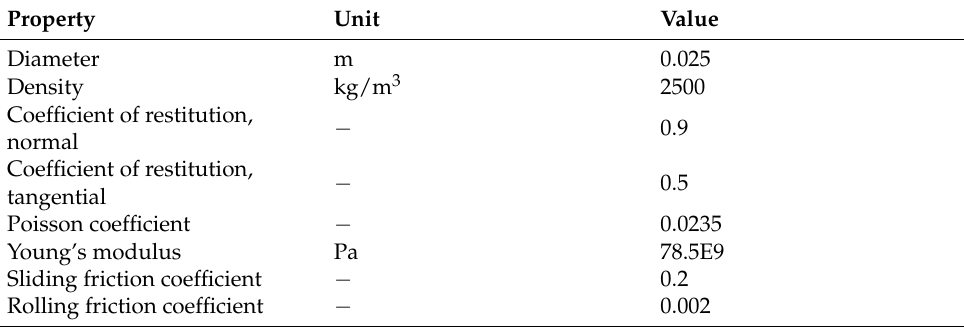
Table 1. Used parameters for the discrete element method (DEM)